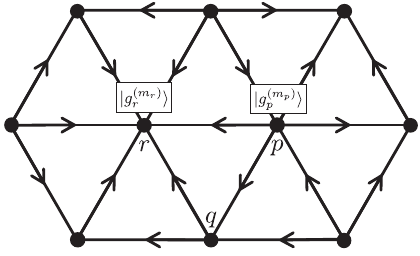
FIG. 7. The evaluation of Ψ (cid:2) on a specific configuration with b one vertex in the j 0 i state and all other vertices, including ˜ G d.o.f. at each vertex. FIG. 5. The auxiliary bosonic SPT has those not pictured, in the j 1 i state along with j 1 i states at every ˜ G j link Hilbert space. The amplitude of this configuration is zero Specifically, at each vertex, we attach a Hilbert space C j with a ˜ G . A natural basis for the total basis labeled by elements of because there is no configuration f g ð m p Þ p g such that Eq. (14) is C j ˜ G j satisfied. This can be seen by the fact that the product of Z Hilbert space ⊗ pq p is then a set of product states for which at p ˜ around either one of the two shaded triangles is 1 while the G is chosen. We refer to this basis of each vertex an element of product states as the configuration basis. An arbitrary element of product of ð − 1 Þ ϵ ( ð g ð mp Þ p Þ − 1 g ð mq Þ q ) around either of these triangles is ð − 1 Þ n ð g p ;g q ;g r Þ ¼ − 1 the configuration basis may be written as jf g ð m p Þ p gi .